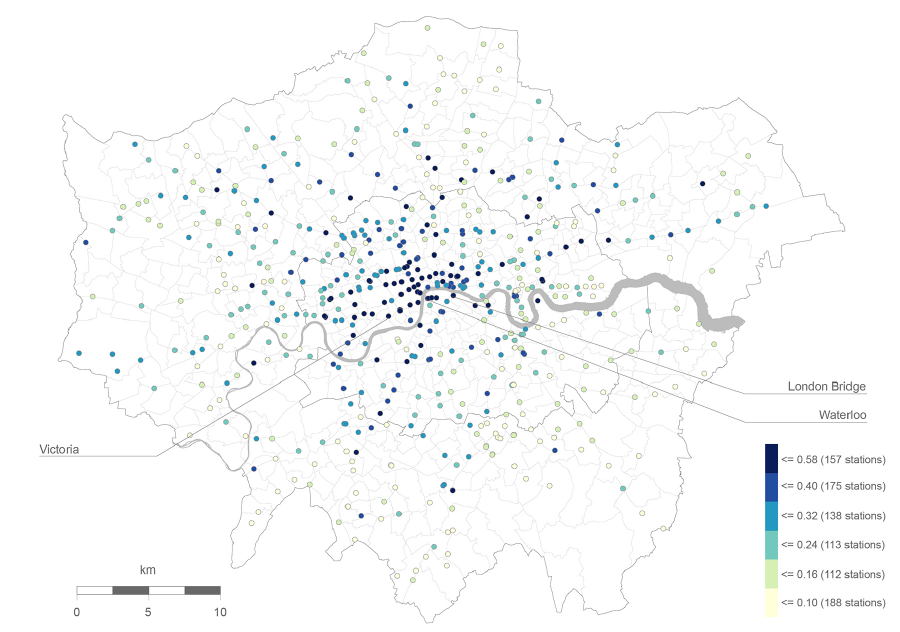
Figure 3: Spatial distribution of the intensity calculated for an average week day.